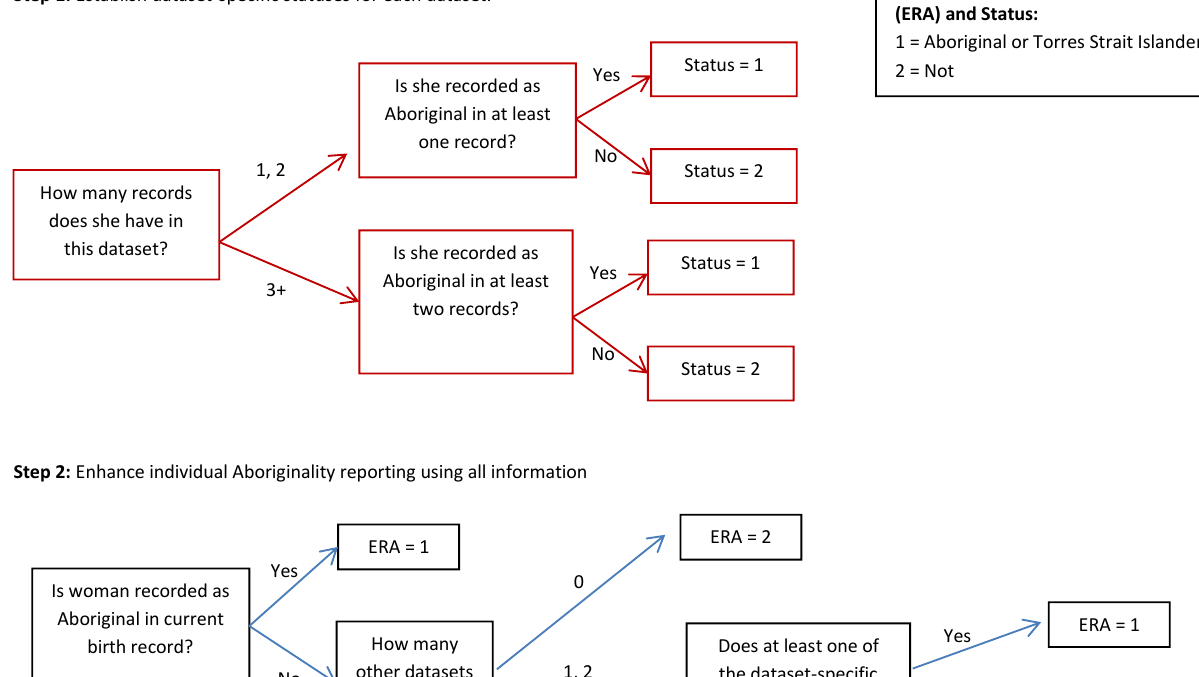
Figure 2: A flow diagram demonstrating the logic used to enhance the reporting of Aboriginality and define study population 3. Step 1: Establish dataset-specific statuses for each